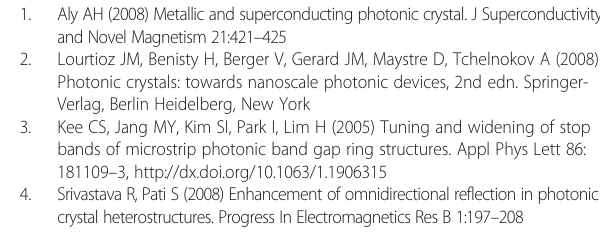
layers, which compose the photonic structure, on the position, number, width, and depth of photonic band gaps (PBGs).